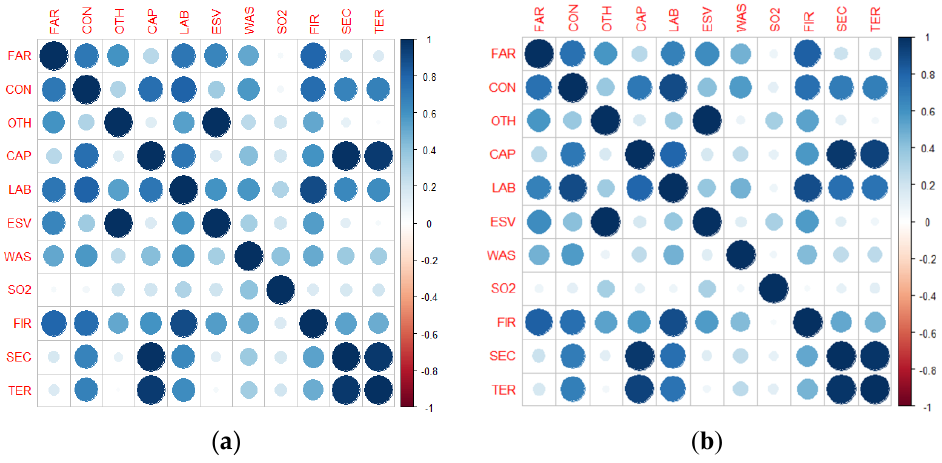
Figure 3. Correlation of inputs and outputs of 2015 ( a ) and 2020 ( b ).